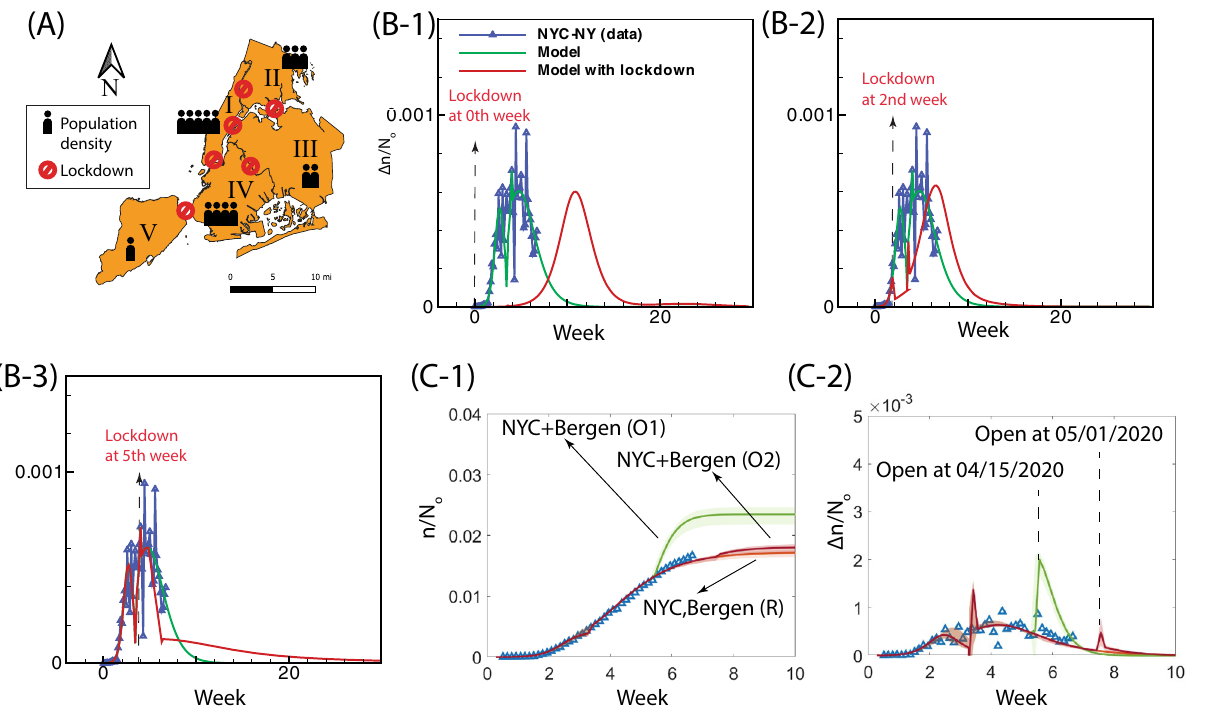
Figure 3. Effect of lockdown and reopening economy on the spread of infection in New York City. ( A ) The strict policy of lockdown is assumed at the borders of five boroughs—Manhattan(I), the Bronx (II), Queens (III), Brooklyn (IV) and Staten Island (V) within New York City. ( B ) The date of initiating lockdown affects daily positive cases (cid:31) n in New York City scaled by total population density N o , where the start of policy enforcement is set at different initiation points: zeroth week (B-1), 2nd week (B-2), and 5th week (B-2), respectively. ( C ) Modeling of infected population (C-1) and increment (C-2) by considering different opening periods for New York City and Bergen county (inner New Jersey circle): ‘NYC+Bergen (O1)’ indicates the reopening economy at 5.5th week; ‘NYC+Bergen (O2)’ indicates the reopening economy at 7.5th week; ‘NYC, Bergen (R)’ indicates the economy remains closed. In ( C ), N o represents the averaged resident population density of both New York City and Bergen (New Jersey); Blue symbols ‘ (cid:31) ’ are the data of the infected population within New York City and Bergen (New Jersey); Plots with shaded area are the modeling results where solid lines represent the median of the prediction and the shaded area indicates the uncertainty. The zeroth week is set at the moment when the total number of infections at the New York City is